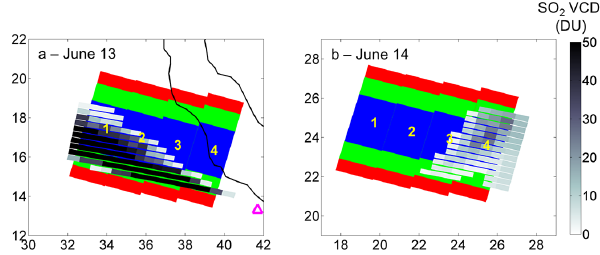
Figure 6. Areas contributing to the limb signal at TH = 16 . 5km (blue), TH = 13 . 5km (green), and TH = 10 . 5km (red) for a homo- geneous, infinite aerosol layer located at 15–18km altitude. SCIA- MACHY SO 2 columns (grey colour scale; only values >2DU are shown) are plotted to indicate the extent of the volcanic plume on 13 June (panel a ) and 14 June (b) . The limb pixel numbers are shown in yellow at their respective